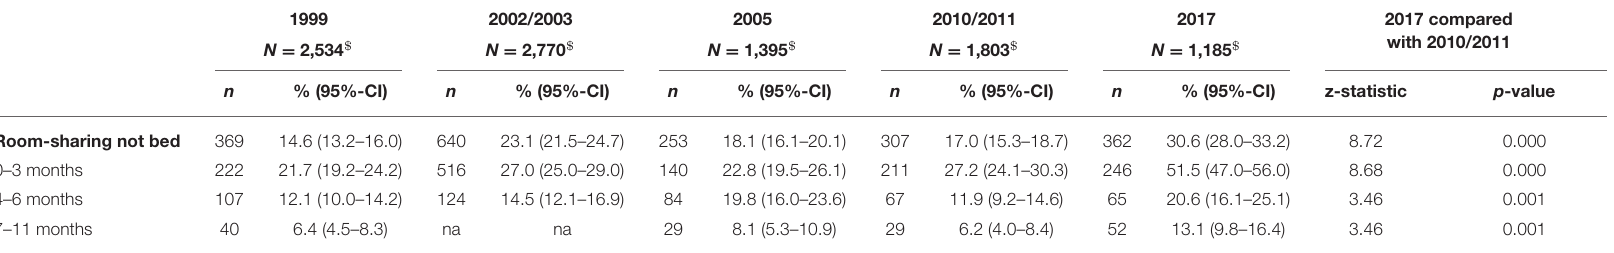
TABLE 6 | Prevalence of room-sharing during sleep in the five survey populations, including prevalence per age category.